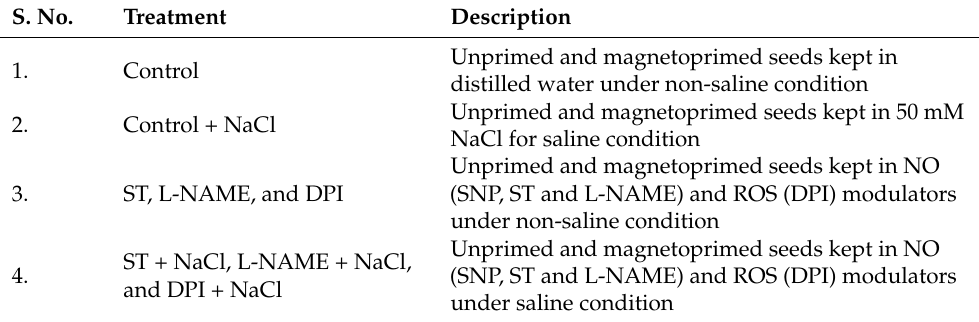
Table 1. The details of treatments used in present